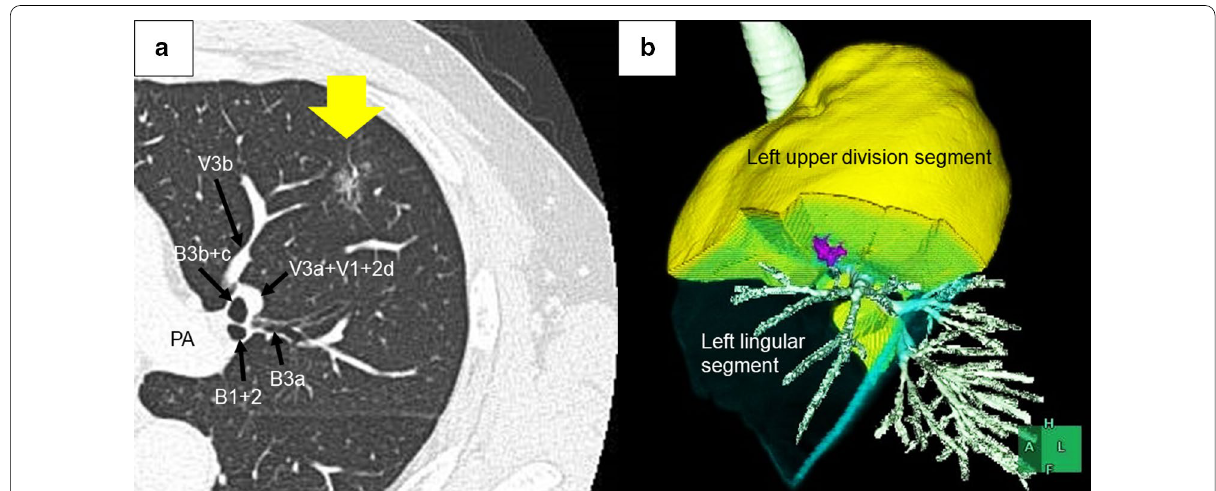
Fig. 1 a Chest computed tomography reveals a partly solid, ground-glass nodule that is highly suspicious for malignancy. b Preoperative three-dimensional computed tomography reconstruction imaging reveals that the nodule (purple) is in the left lingular segment, but is close to the intersegmental plane between the left upper division segment and the left lingular